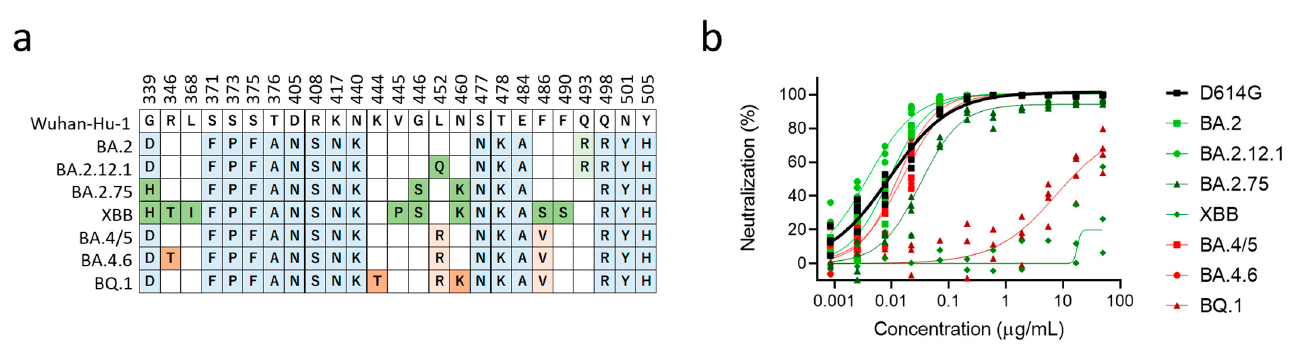
Figure 2. Bebtelovimab neutralization efficacy against the Omicron subvariants. ( a ) Location of mutations in the receptor-binding domain proteins of the Omicron subvariants: BA.2 and its three derivatives, BA.2.12.1, BA.2.75, XBB, and BA.4/5, and its two other derivatives, BA.4.6 and BQ.1.1. Conserved mutations among Omicron subvariants are highlighted in blue. Unique mutations in BA.2 derivatives and BA.4/5 derivatives are highlighted in green and red, respectively. Top number is the residue according to the spike protein of SARS-CoV-2 Wuhan-Hu-1. Data are adapted from Coronavirus Antiviral & Resistance Database of Stanford University “https://covdb.stanford.edu/ (accessed on 1 November 2022). ( b ) Neutralization efficacy of bebtelovimab in 293T/ACE2 cells. n = 4 technical